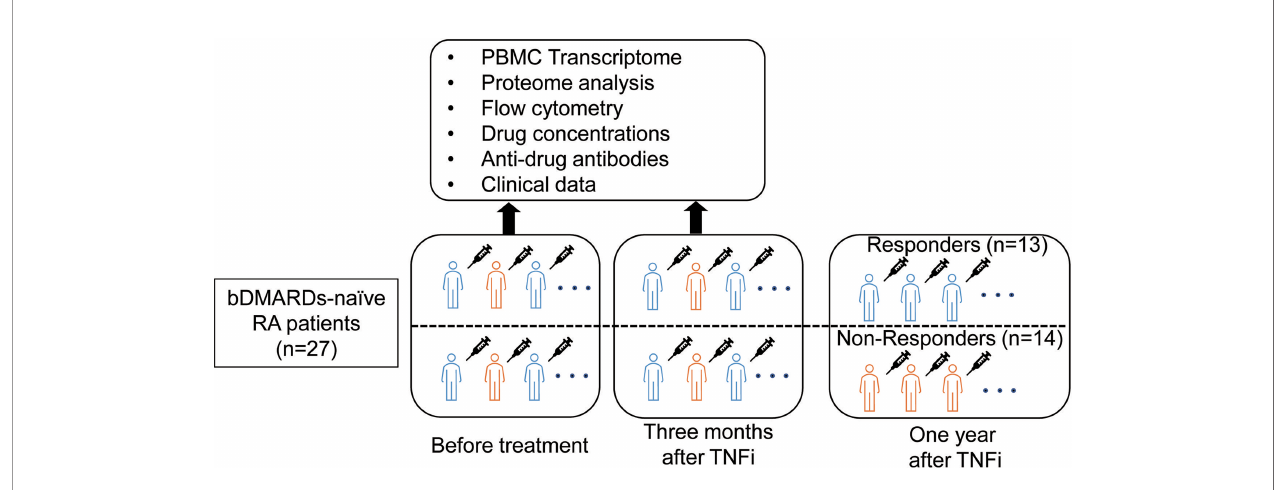
FIGURE 1 | Overview of the